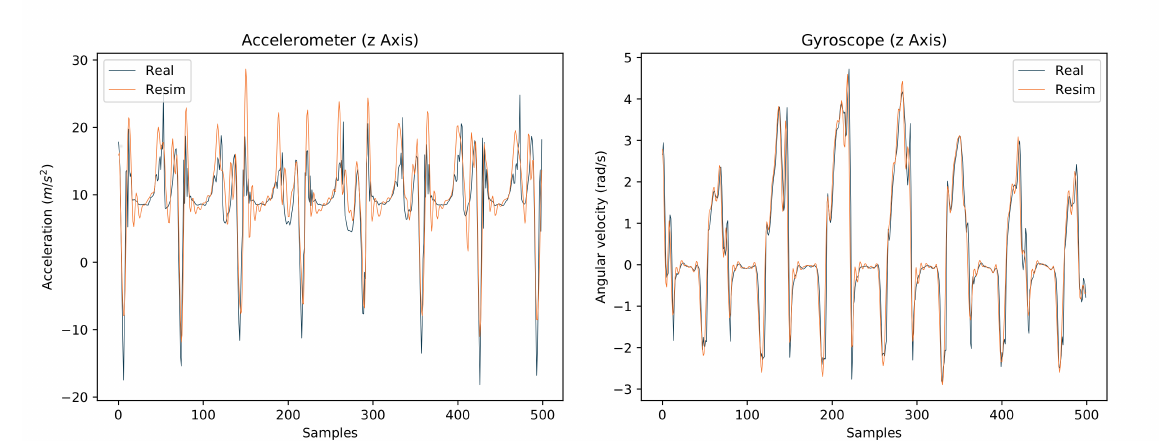
Figure 6. Comparison between real and re-simulated IMU data from the right foot from a capturing setup where IMUs were mounted on a person during walking and were additionally tracked with a marker based optical system. The frequency was 60 Hz, i.e., 60 samples correspond to one